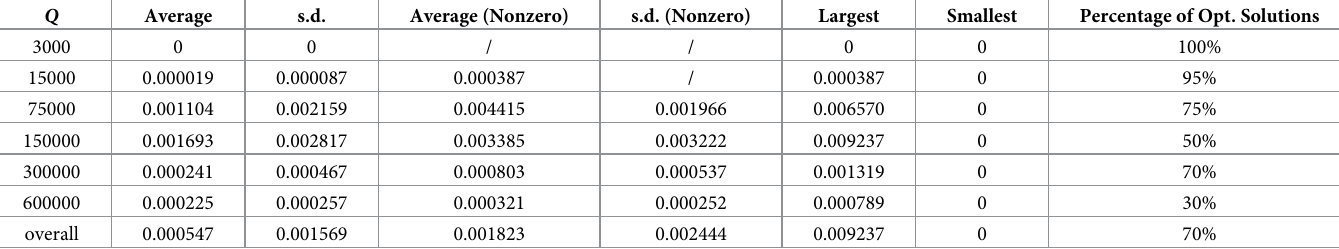
Table 14. Statistics of optimality gaps for